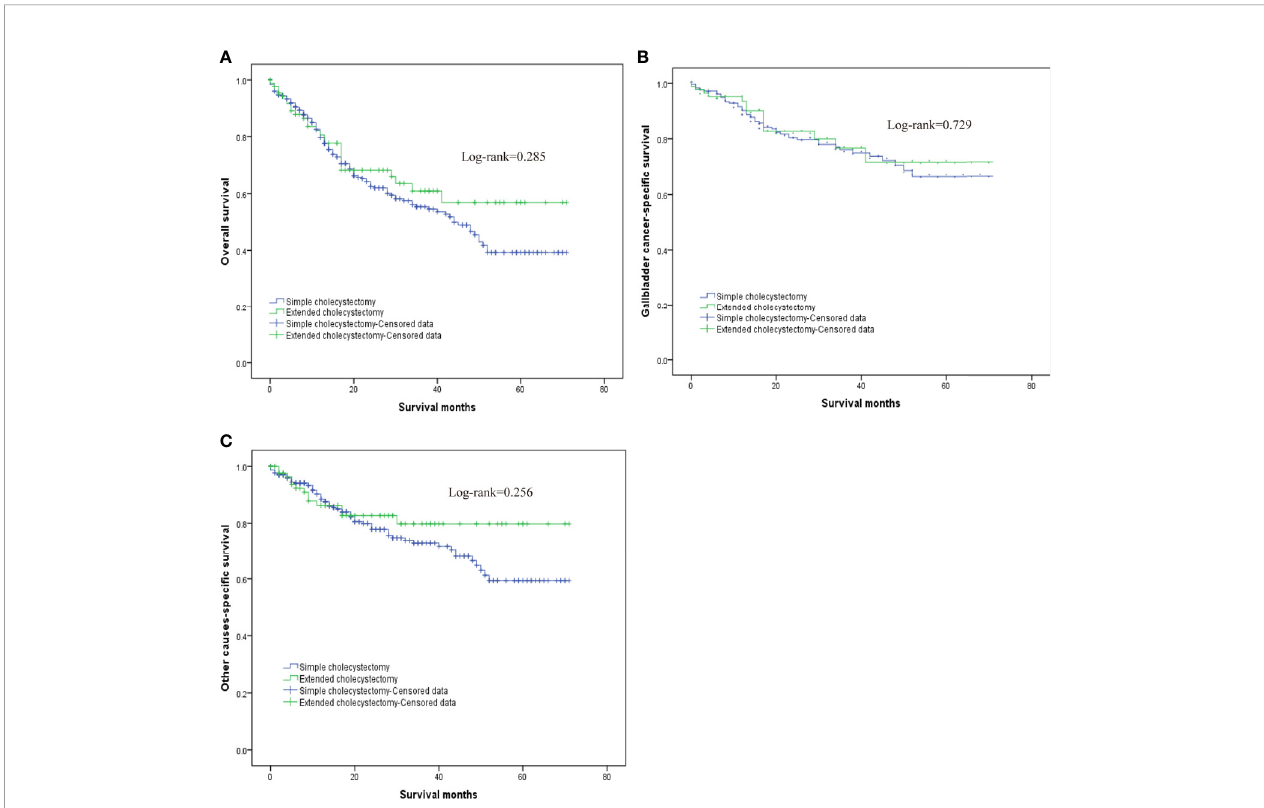
FIGURE 2 | The overall survival for T2 gallbladder cancer comparison after propensity score matching between patients who underwent simple cholecystectomy and patients who underwent extended cholecystectomy. (A) Kaplan – Meier plots for overall survival. (B) Kaplan – Meier plots for cumulative gallbladder cancer-speci fi c survival. (C) Kaplan – Meier plots for cumulative other cause-speci fi c